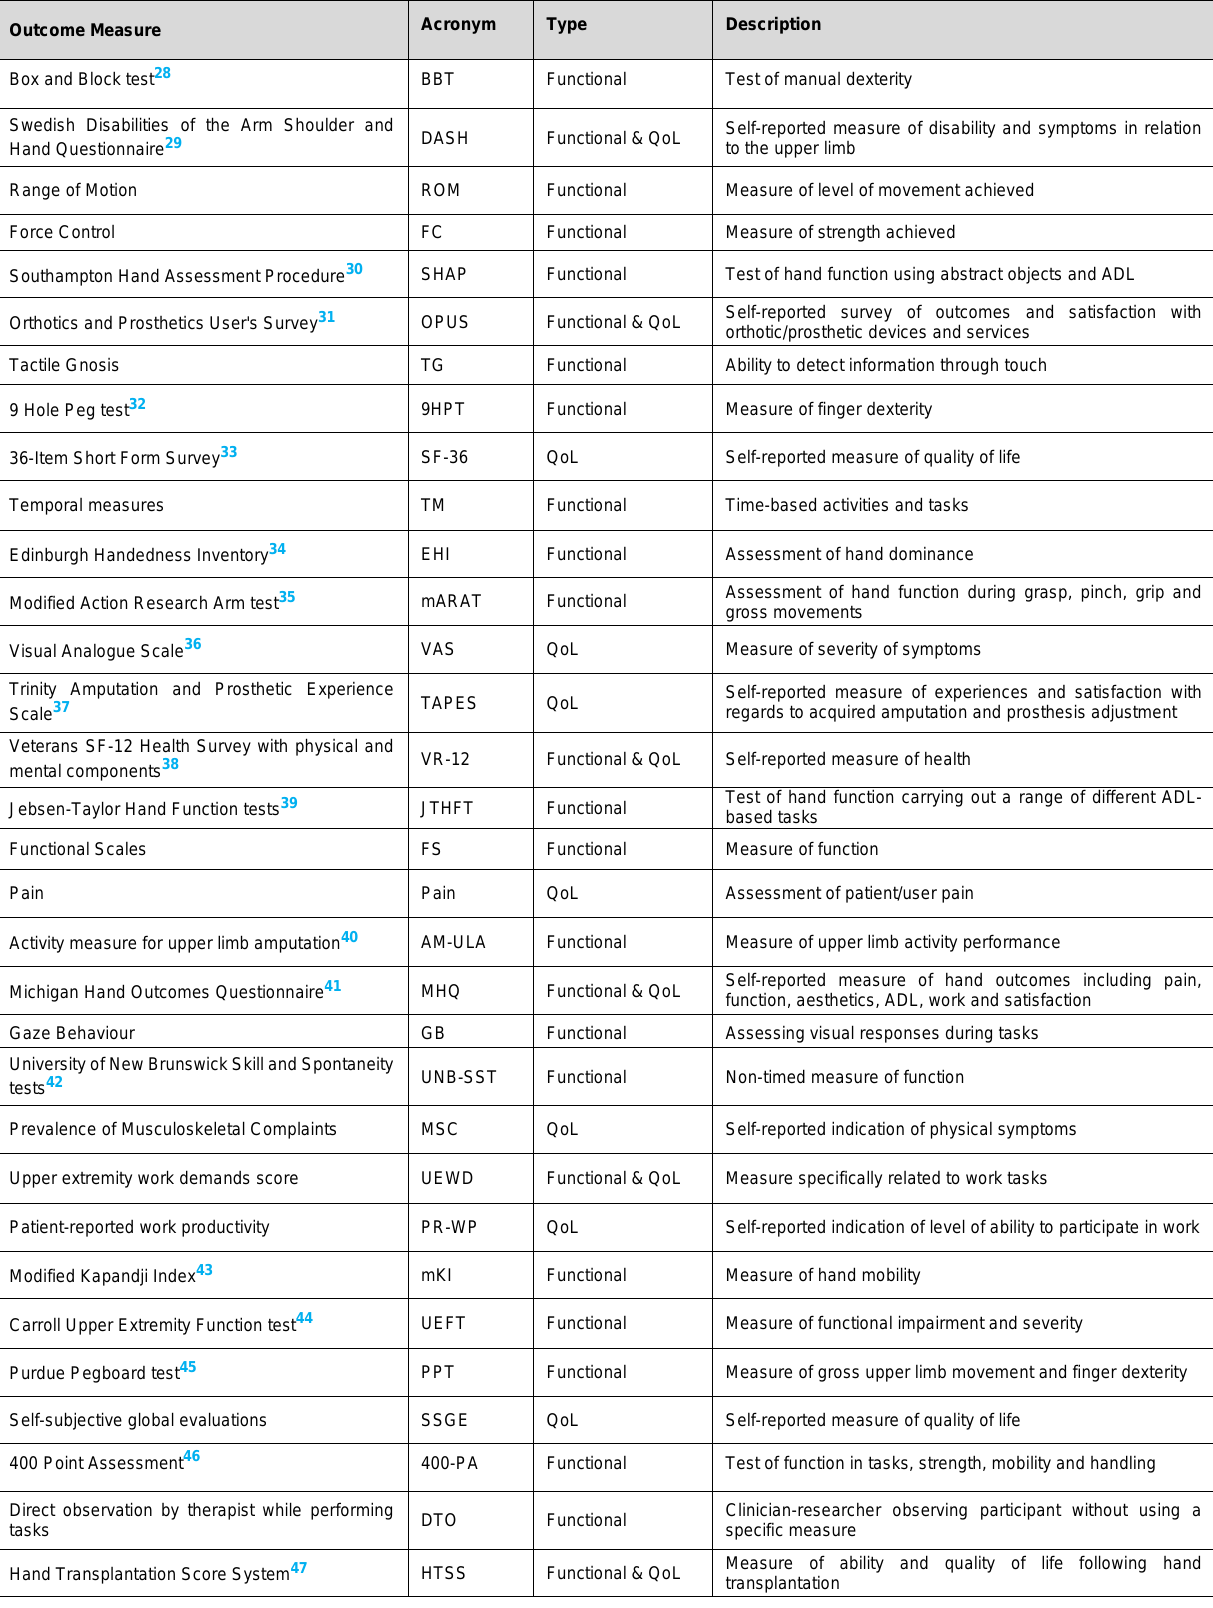
Table 4: List of outcome measures, acronyms, type and description of measures. Outcome